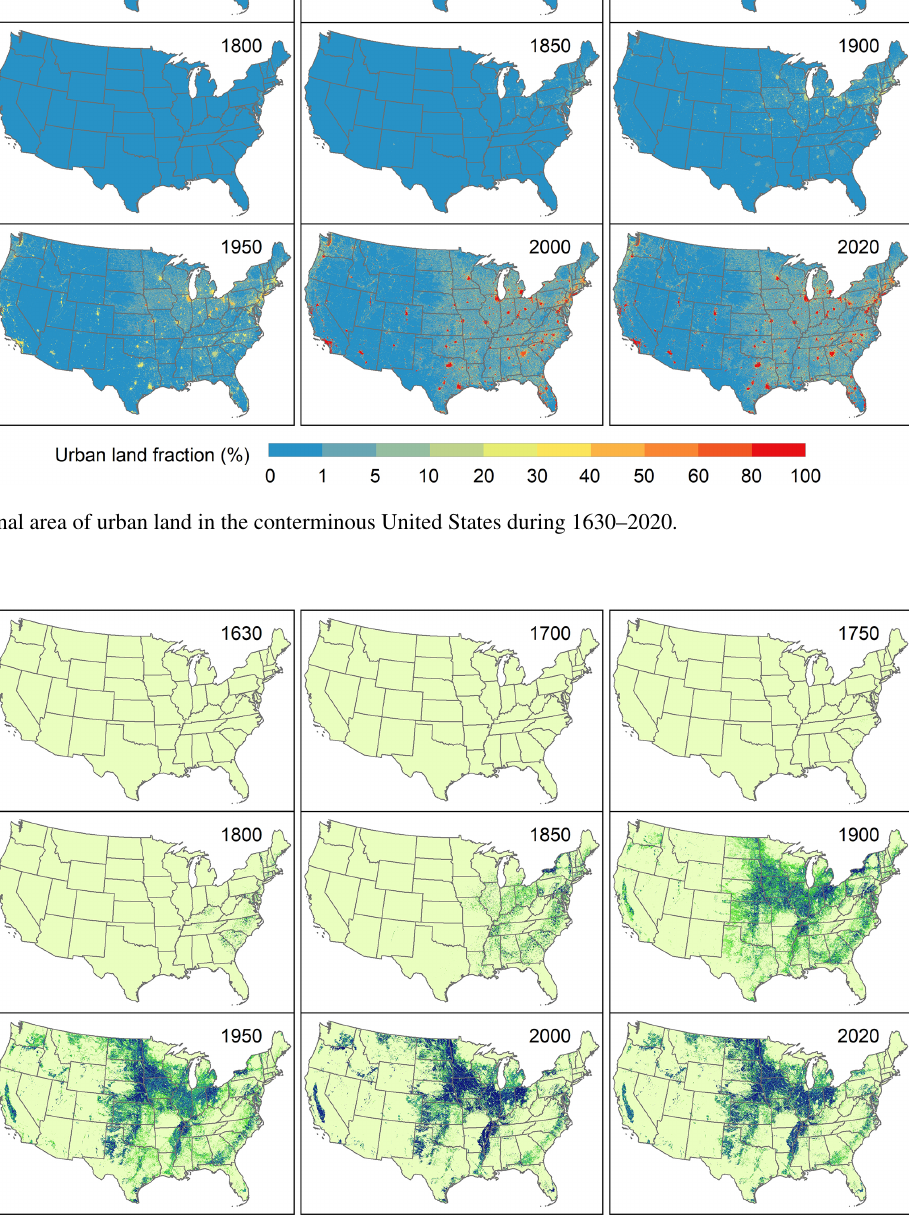
Earth Syst. Sci. Data, 15, 1005–1035, 2023